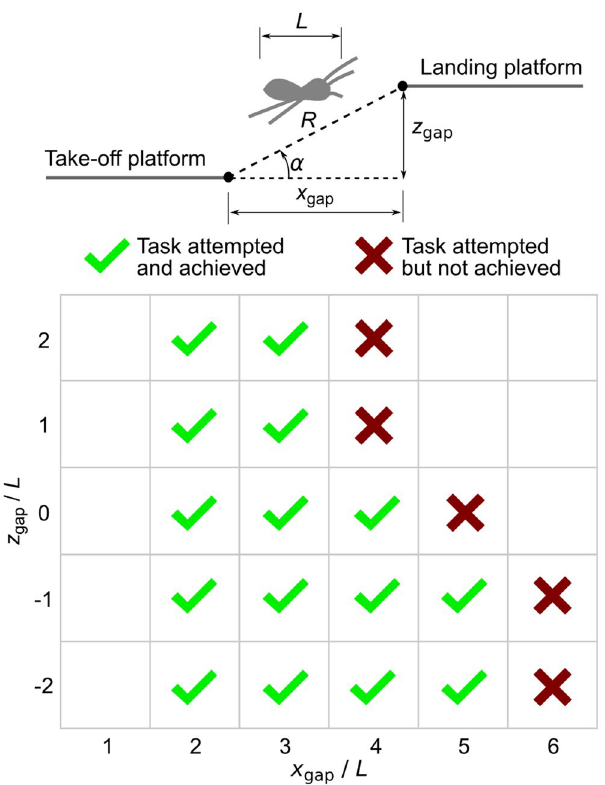
Figure 2. Definition of the jumping task and task test matrix. The jumping task is defined through the gap horizontal and vertical distances as ratios of the reference body length. Ticks indicate successful jumping attempts, whereas crosses demonstrate jumping tasks that the spider was presented with but refused to